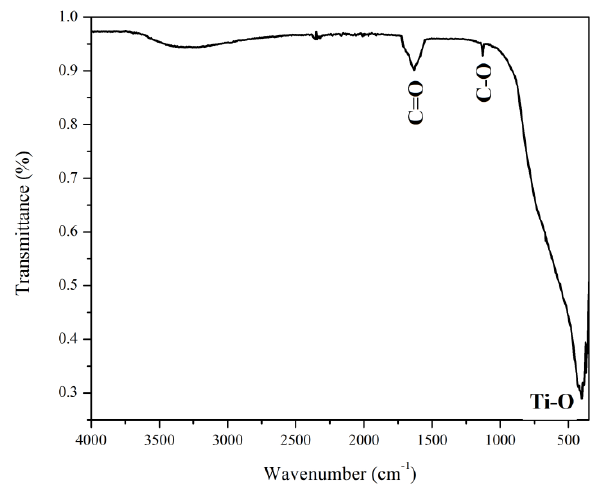
Figure 1. FTIR spectra of MWCNTs_TiO 2 .